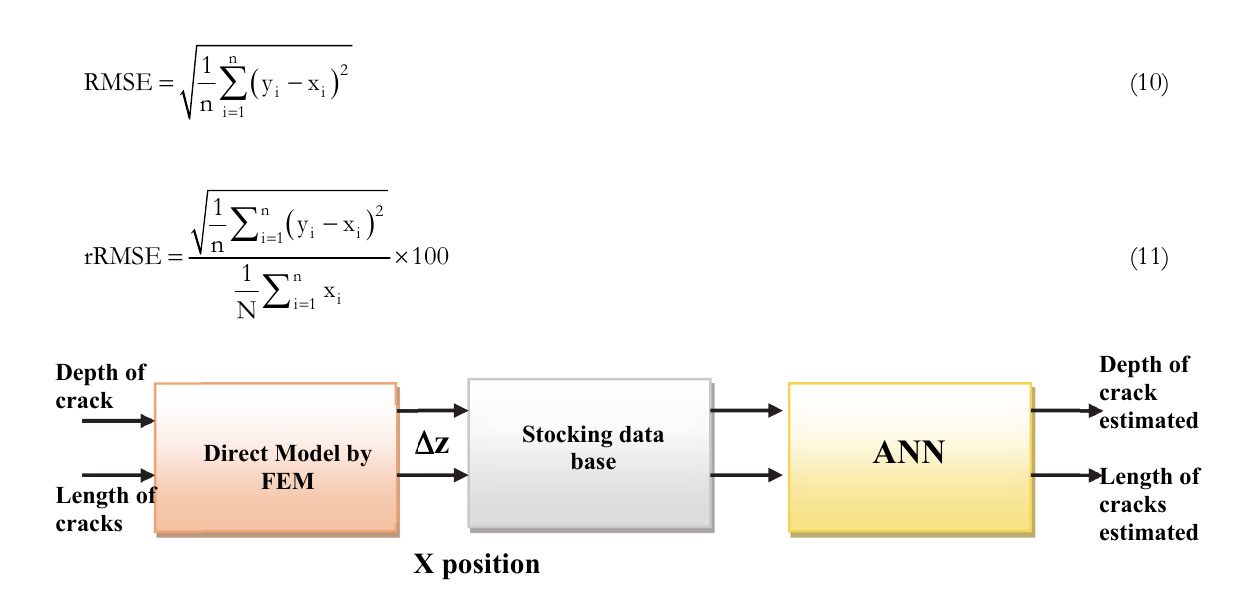
Figure 6: Inverse problem RN with two inputs and two outputs.